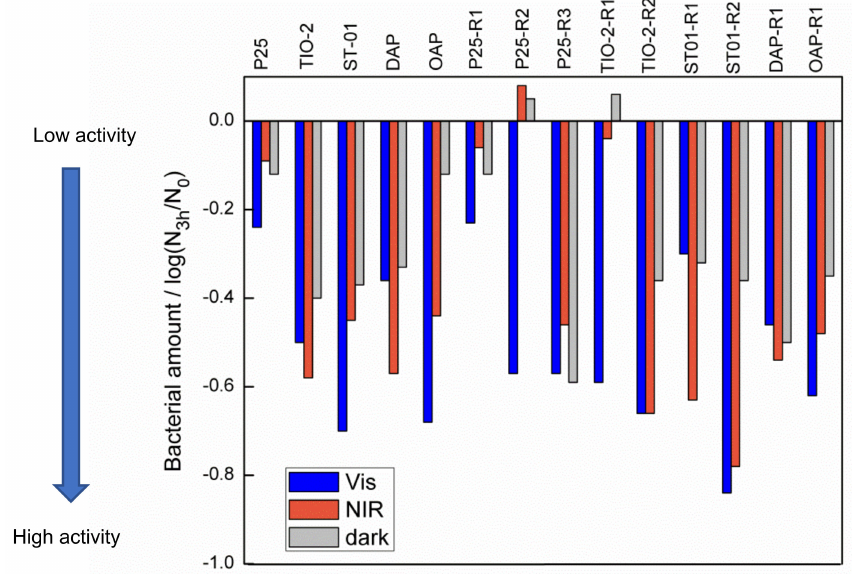
Figure 10. Bactericidal activity of black and pristine titania, shown in the decreased number of cells at 3 h from initial